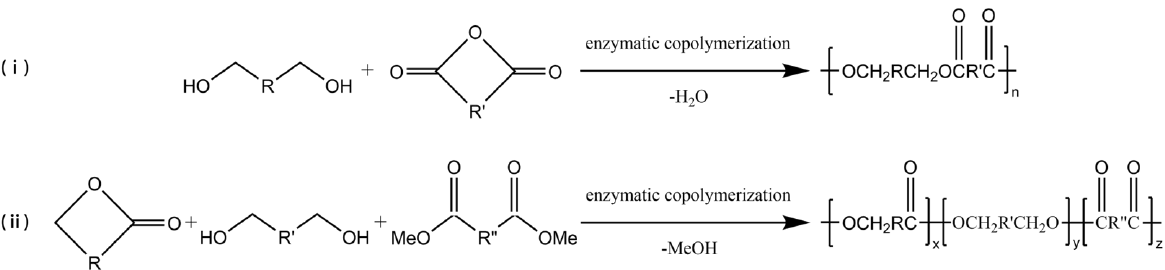
Figure 3. The enzyme-catalyzed copolymerization of ( ⅰ ) diols and carboxylic anhydride ( ⅱ ) lactones, diols, and diacid derivatives.